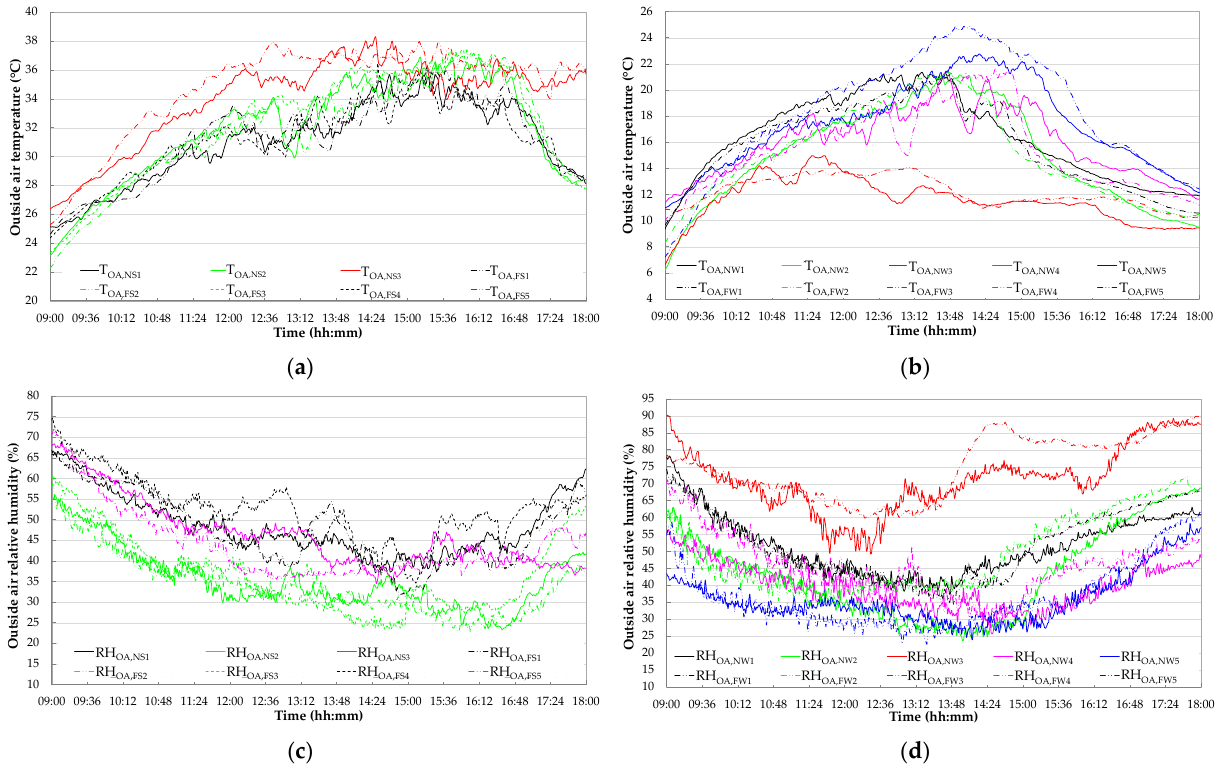
Figure A1. Measured values of T OA during summer tests ( a ), measured values of T OA during winter tests ( b ), measured values of RH OA during summer tests ( c ), measured values of RH OA during winter tests ( d ).